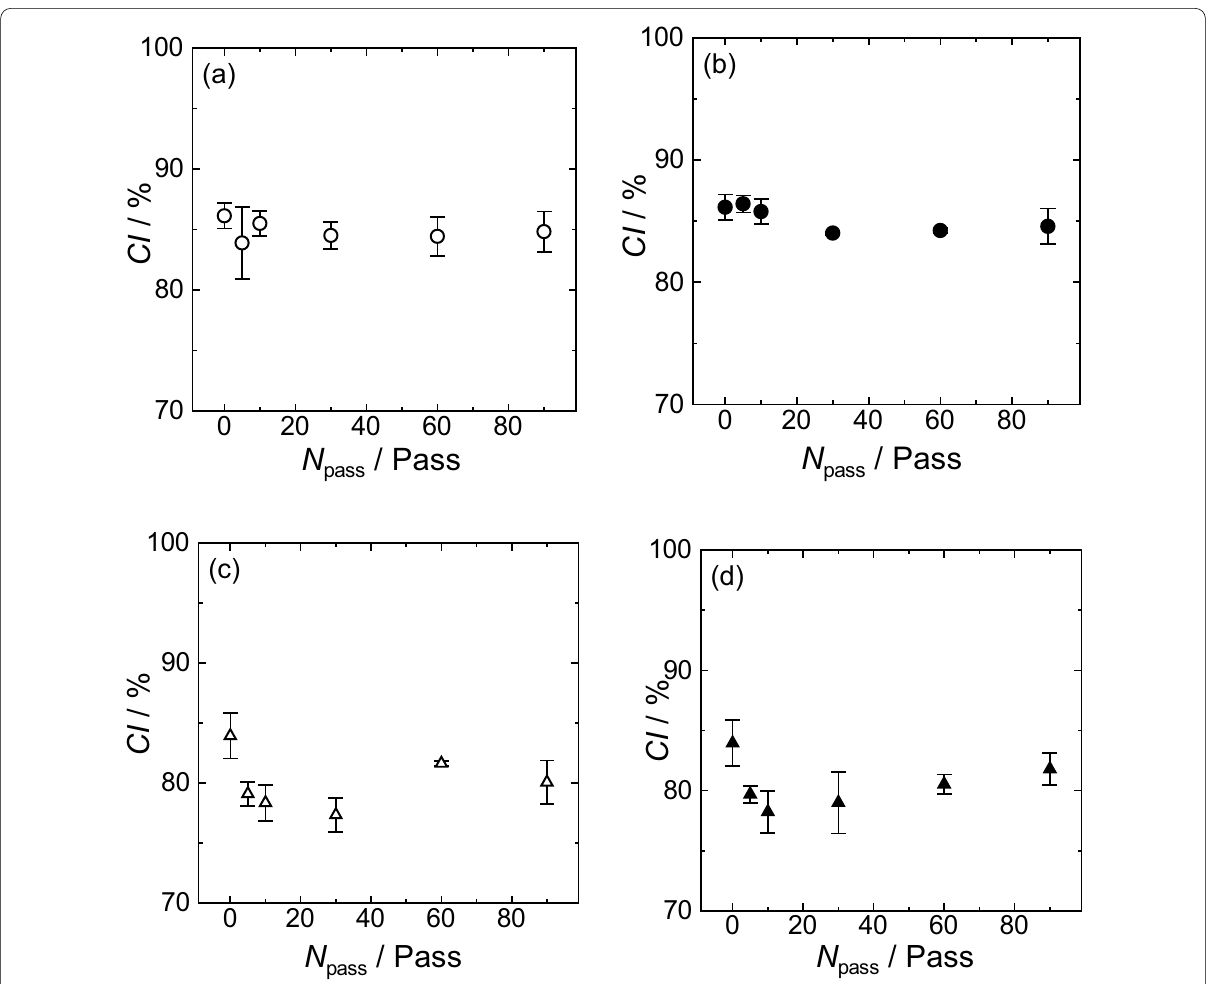
Fig. 6 Relationships between product crystallinity and ACC conditions: a U100, b U200, c M100, and d